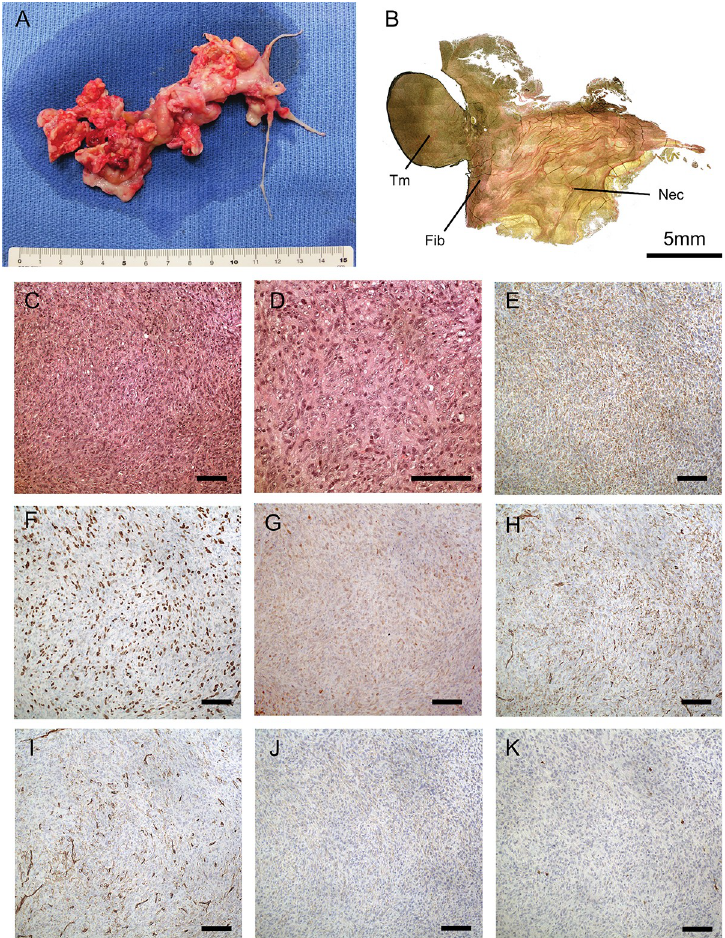
Fig 1. Primary tumor and pathological slides. (A). Photo-macrography of the resected specimen of PIS. B: Composite photograph of the specimen derived from the left main pulmonary artery stained by elastic-van Gieson staining. The specimen contained different tumor, fibrotic, and necrotic components. (C) Low magnification photomicrographs ( × 200) with hematoxylin-eosin (HE) staining; (D) High-magnification photomicrographs with HE staining ( × 400). E-J were photomicrographs with immunohistochemistry. (E) Vimentin, (F) Murine double minute 2 (MDM2), (G) Cyclin-dependent kinase 4 (CDK4), (H) CD31, (I) CD34, (J) α -smooth muscle actin. (K) S-100 protein. Tm: tumor component; Fib: fibrotic component; Nec: necrotic component. Scale bar shows 100 μ m unless otherwise stated.